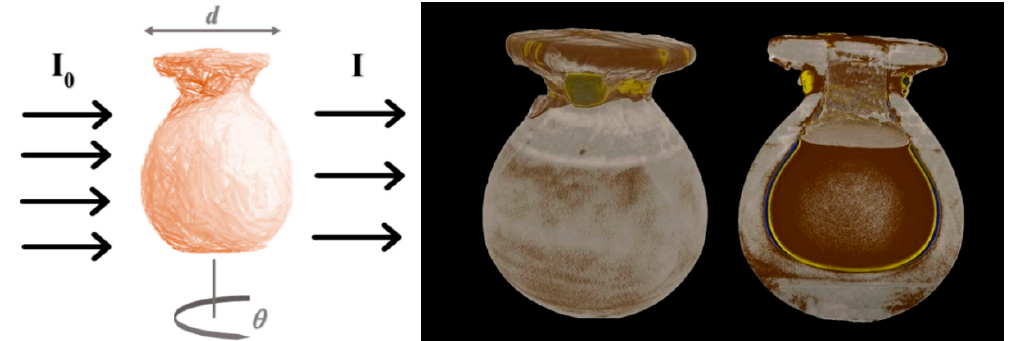
Figure 2. Neutron radiography and tomography. ( Left ) diagram of a standard radiographic and tomography set-up; ( Right ) radiography and tomography on a sealed Egyptian vase [32].